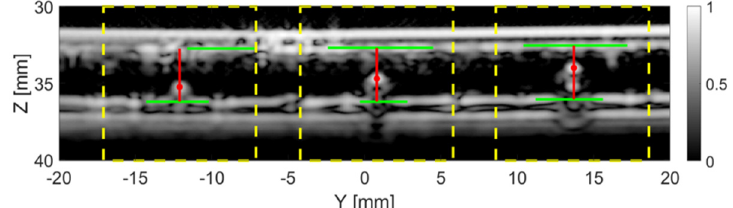
Figure 10. Block diagram to illustrate the particle detecting algorithm.